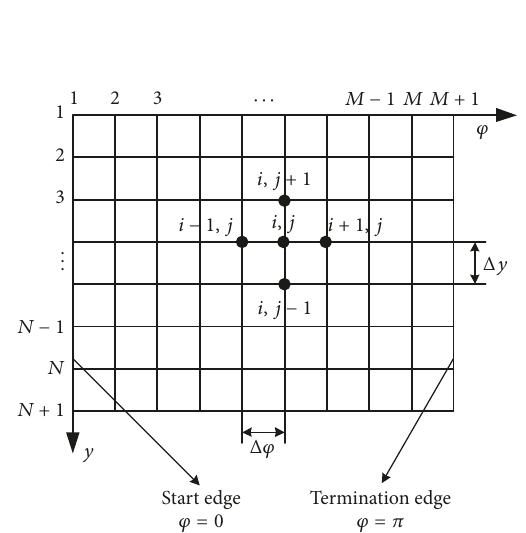
Figure 5: Grid of oil film region of the piston